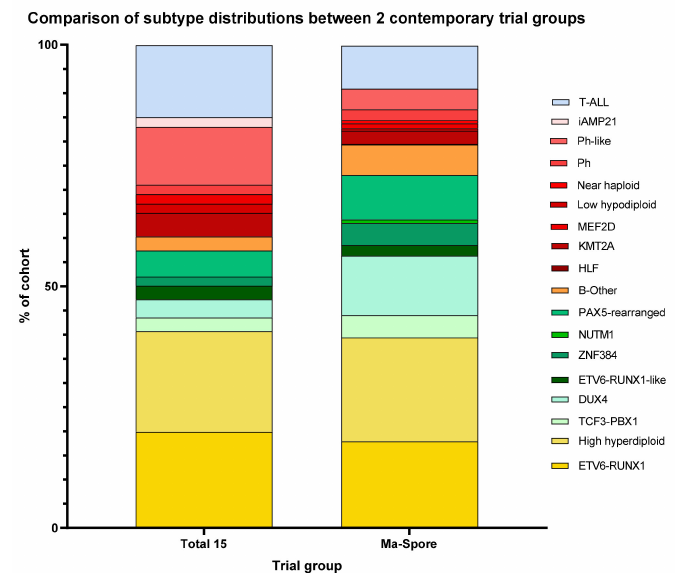
Figure 2. Spectrum of molecular subtypes of childhood ALL in the St Jude Total 15 cohort in the USA and the Malaysia-Singapore (Ma-Spore) cohort in Asia. The bar charts depict the estimated frequencies of each subtype of ALL among patients treated in these two frontline trials, updated with the current taxonomy of novel genetic abnormalities. The distribution profile differs slightly between these two cohorts, which is plausibly race-related, e.g., in proportions of DUX4 , Ph-like, or T-ALL. Among the B-ALL subgroup, favorable-risk subtypes are in shades of yellow, intermediate-risk subtypes are in shades of green, and high-risk subtypes are in shades of red; B-Other is noted in orange; T-ALL is represented separately in blue. Data from Total 15 are reproduced with permission from Pui et al. Nat Rev Clin Oncol 2019. The prognosis of genetic subtypes possibly varies slightly between trial groups due to differences in risk stratification and treatment intensity, e.g., currently DUX4 is now regarded by some trials (such as the recent St Jude Total 16 trial) as